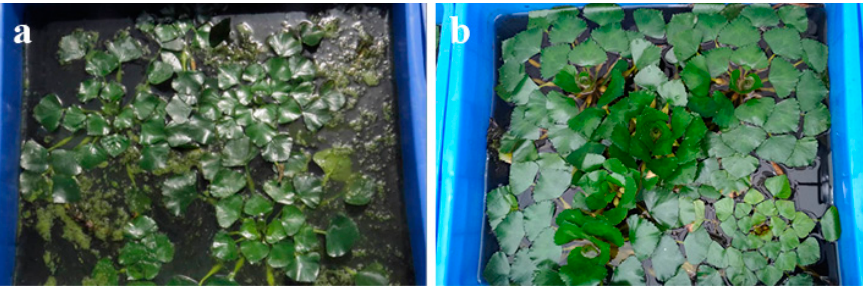
Figure 2. Growth status of Ludwigia adscendens in swine manure wastewater: (a) day 0 and ( b ) day 15.